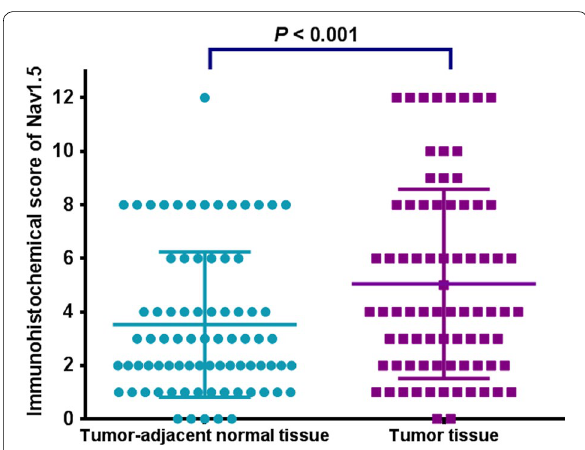
Fig. 2 Nav1.5 expression level in colon cancer and matched tumor- adjacent normal tissues from 78 patients detected by IHC staining of TMA (5.1 3.5 vs. 3.5 2.7, P < ± ±